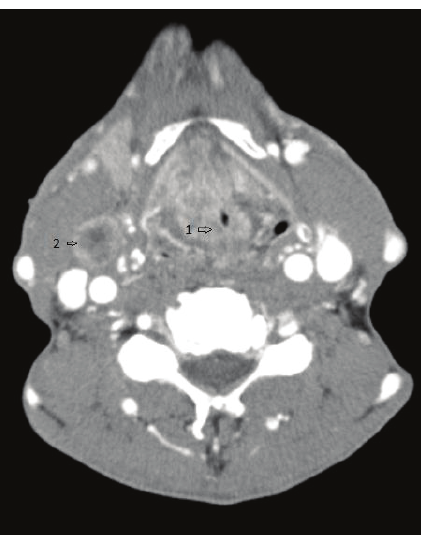
Figure 1: Supraglottic-level CT showing airway narrowed by glottis mass (1) and lymph node metastasis (2).